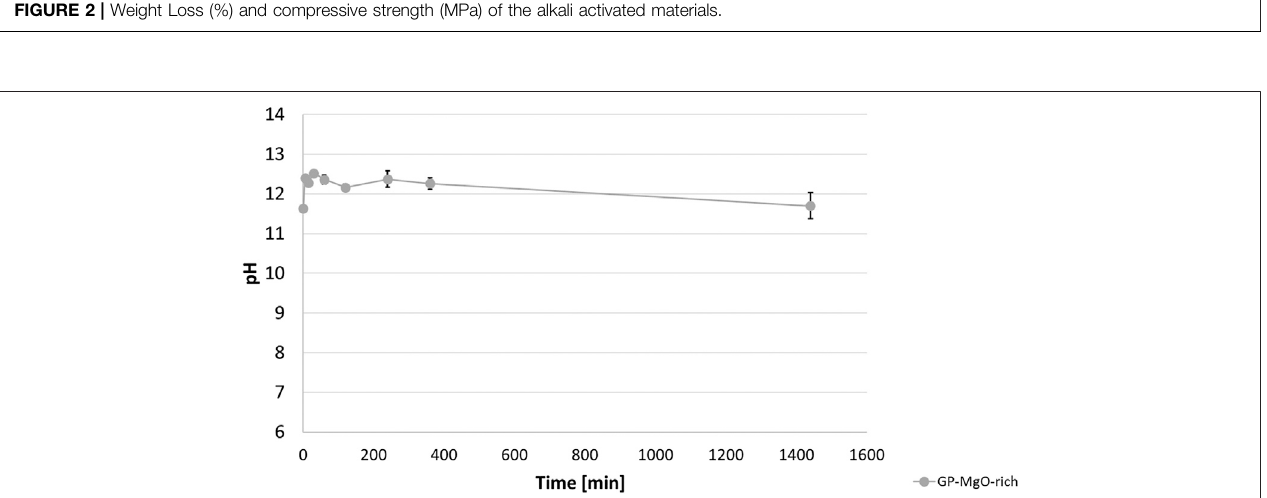
FIGURE 3 | Monitoring the pH of water where a piece of sample GP-MgO-rich (S/L (cid:1) 1:10) was immersed at room temperature.